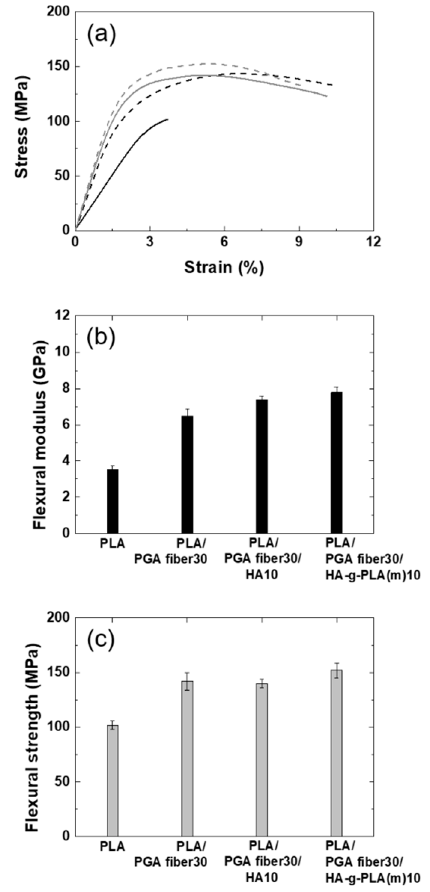
Figure 3. ( a ) Flexural stress–strain curves, ( b ) flexural modulus, and ( c ) flexural strength of PLA and its composites: PLA (black solid line); PLA/PGA fiber30 (black dash line); PLA/PGA fiber30/HA10 (gray solid line); PLA/PGA fiber30/HA-g-PLA(m)10 (gray dash line).